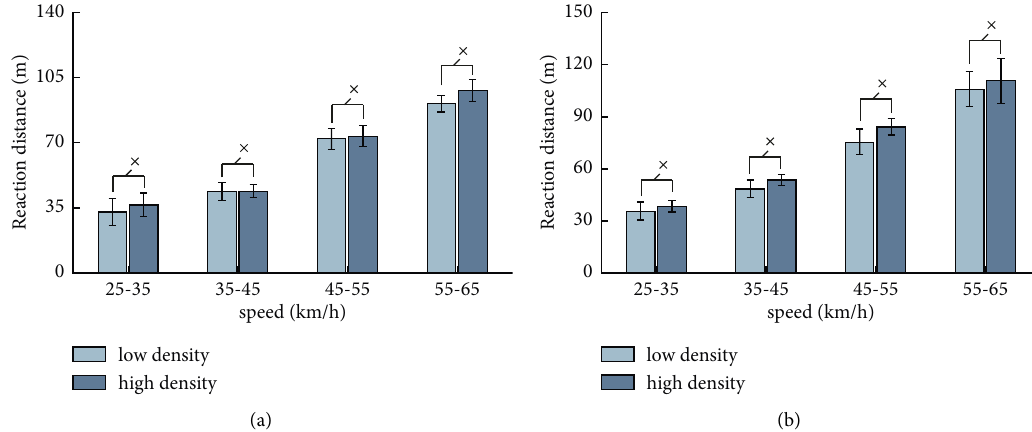
Figure 15: AVOVA results for traffic density on the second reaction distance. (a) Freedom; (b) follow.